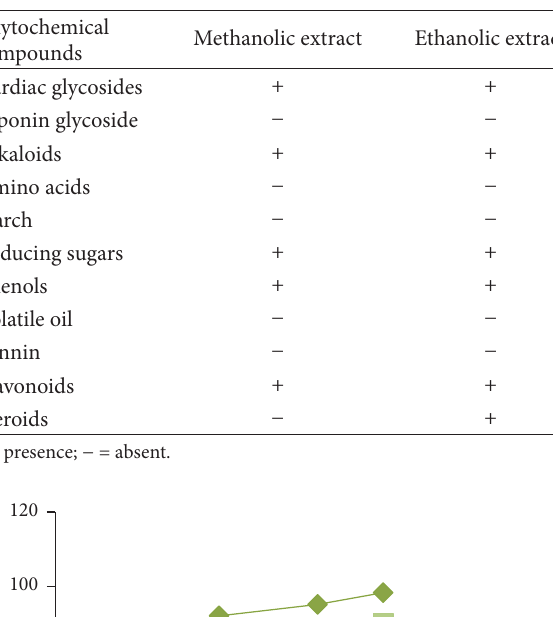
Table 3: Phytochemical analysis for the methanolic and ethanolic extract of E.intermedia .